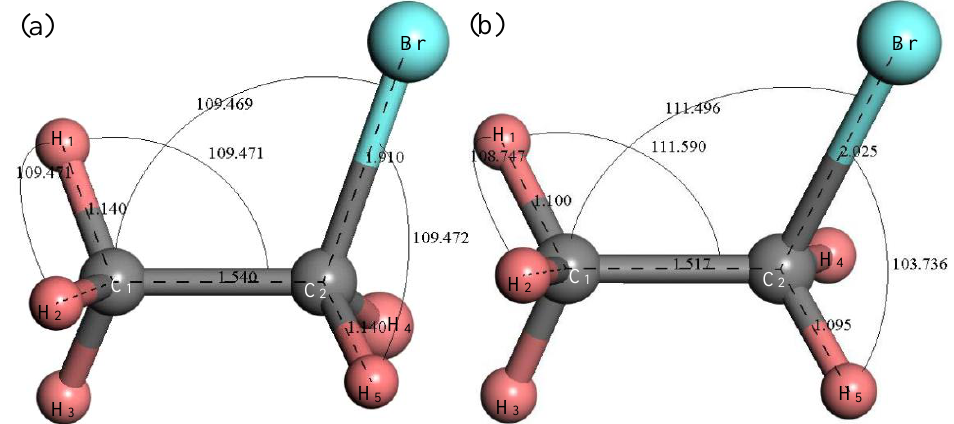
Figure 2. Molecular model of C 2 H 5 Br molecule. ( a ) Initial model; ( b ) Optimized model. The unit of the angle in the image is (°), and the unit of the bond length is angstrom (Å).